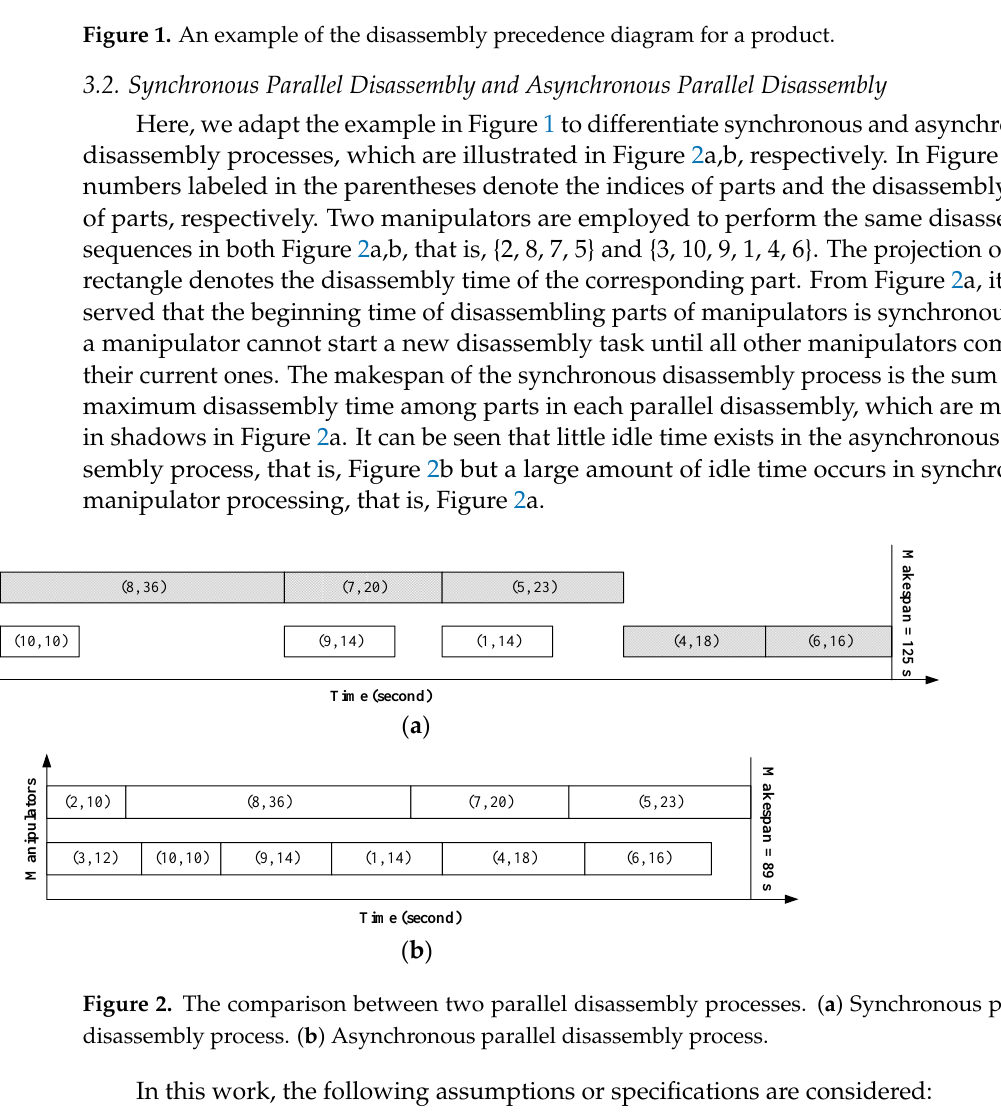
Figure 1. An example of the disassembly precedence diagram for a product.